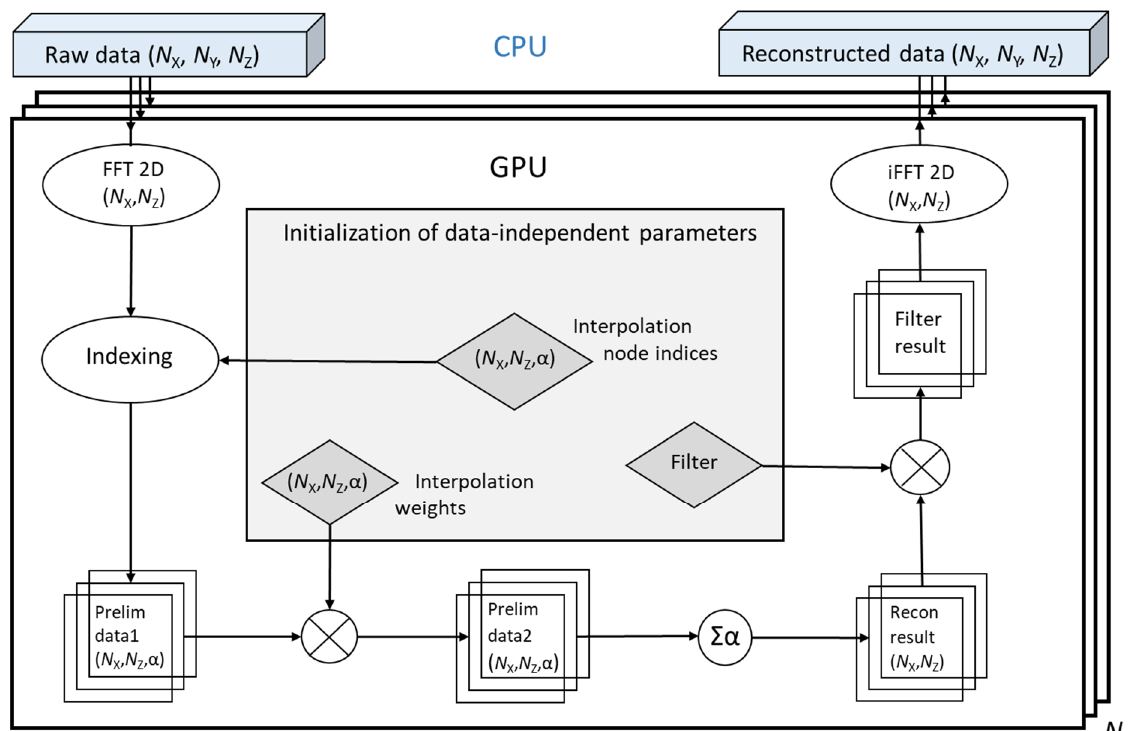
Figure 2. Block diagram of the GPU-FD algorithm. Represented in the center are pre-processed matrices containing the reconstruction indices ( with α denoting the number of interpolation nodes), the complex interpolation weights used for interpolation and the filter matrix.